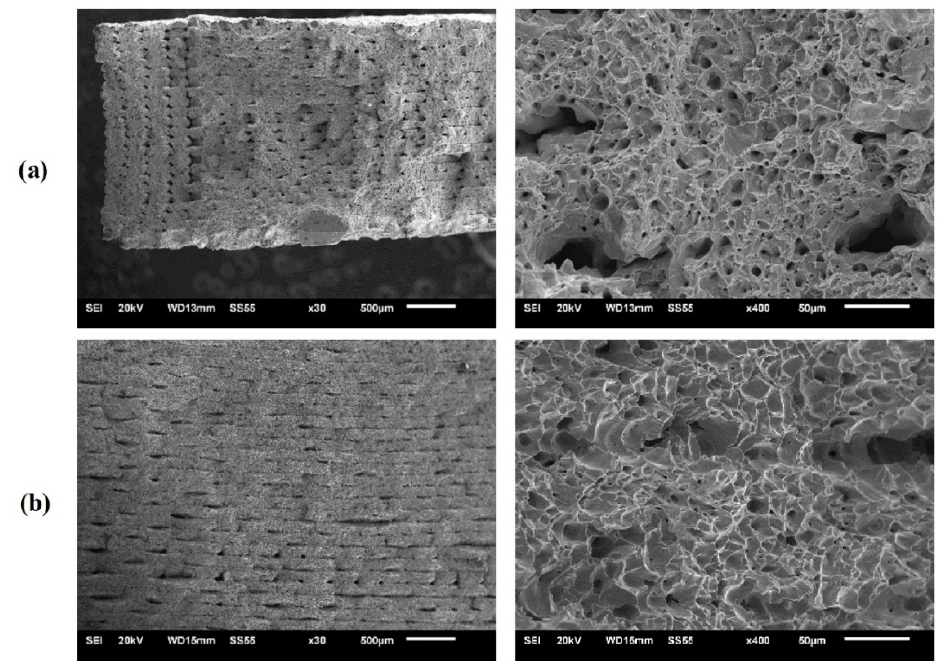
Figure 9. Fracture surface structure of copper MEAM parts. ( a ) Tensile sample. ( b ) Charpy sample.